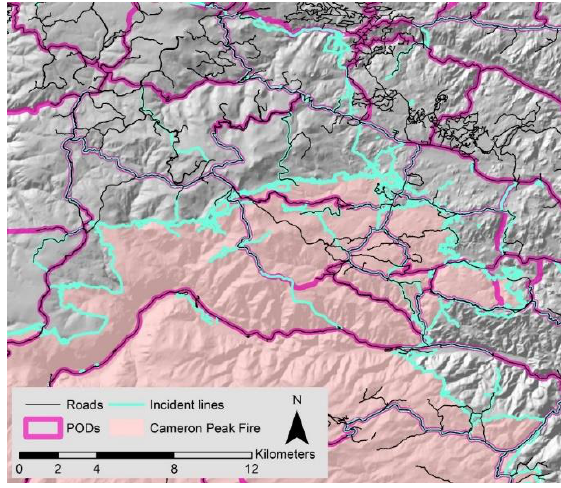
Figure 5. Map of the northern portion of the Cameron Peak Fire, potential wildland fire operational delineation (POD) boundaries, local roads, and incident lines (control lines and roads improved for access documented by the management team).